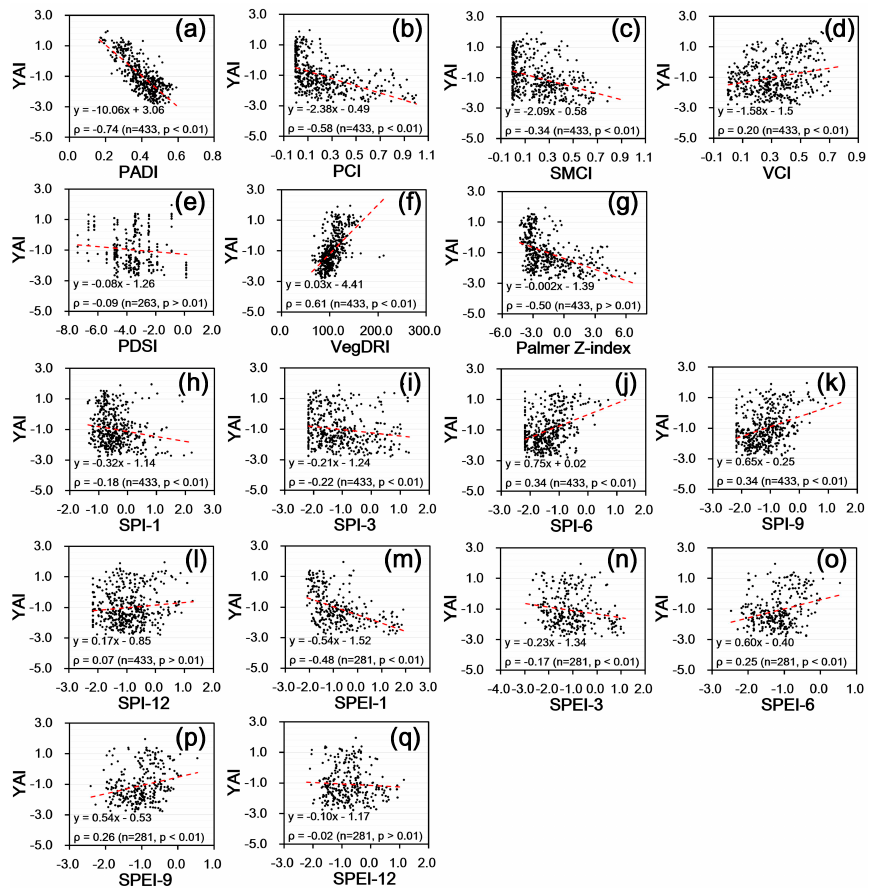
Figure 7. Scatter plot between yield (YAI) and drought indices for all counties in the study area, including ( a ) PADI, ( b ) PCI, ( c ) SMCI, ( d ) VCI, ( e ) PDSI, ( f ) VegDRI, ( g ) Palmer Z-index, ( h ) SPI-1, ( i ) SPI-3, ( j ) SPI-6, ( k ) SPI-9, ( l ) SPI-12, ( m ) SPEI-1, ( n ) SPEI-3, ( o ) SPEI-6, ( p ) SPEI-9, and ( q ) SPEI-12. The